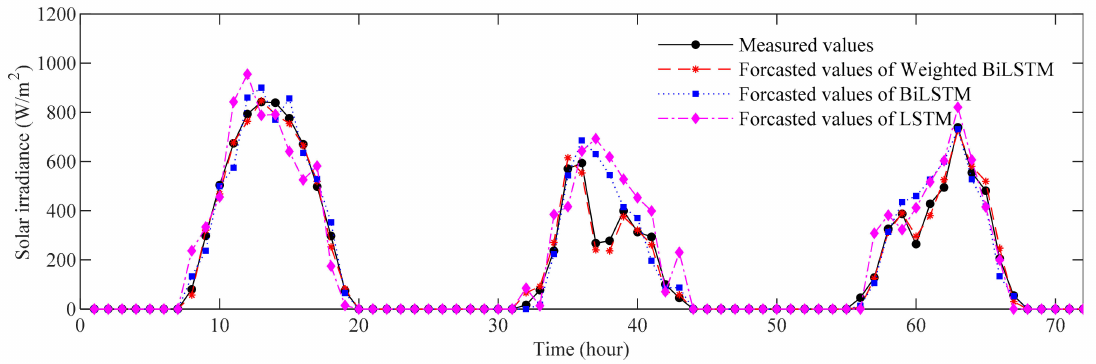
Figure 8. Forecast results obtained for cloudy